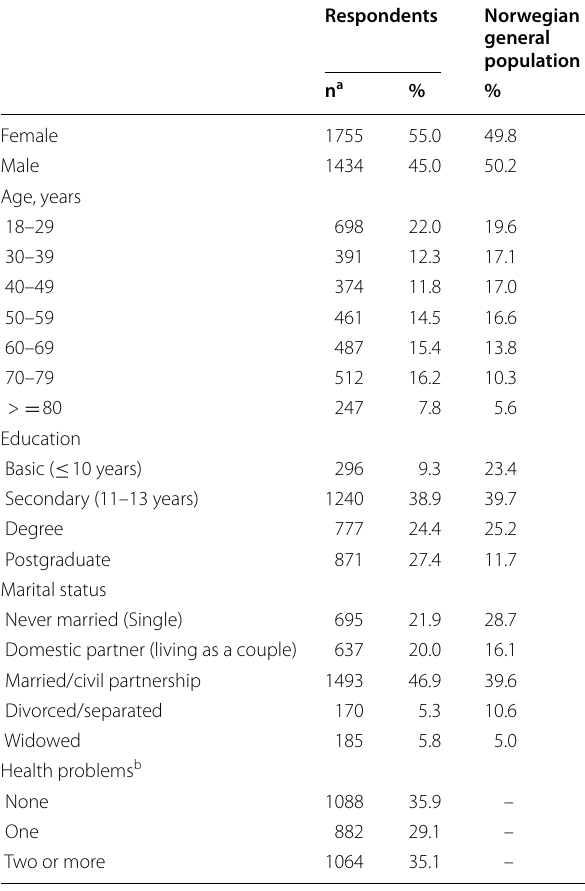
Table 1 Respondent characteristics (n general